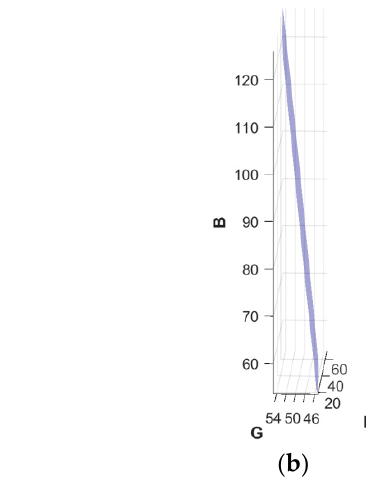
Figure 1. ( a ) A very thin metamer mismatch body (MMB) found for the Point Grey Grasshopper2 camera (and similarly for the Hasselblad H2); ( b ) The same MMB from a different viewing angle.